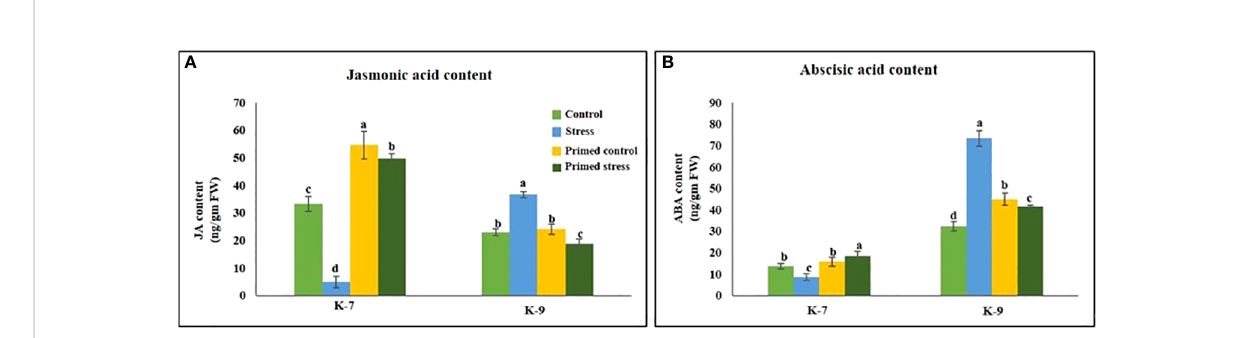
FIGURE 11 Effect of melatonin priming on the contents of (A) jasmonic acid and (B) abscisic acid in drought-sensitive (K-7) and drought-tolerant (K-9) varieties under drought stress. Data represents mean values ± SD of minimum 3 independent experiments. Different alphabets within the group represent signi fi cant differences among treatments according to Duncan ’ s multiple range test at P <